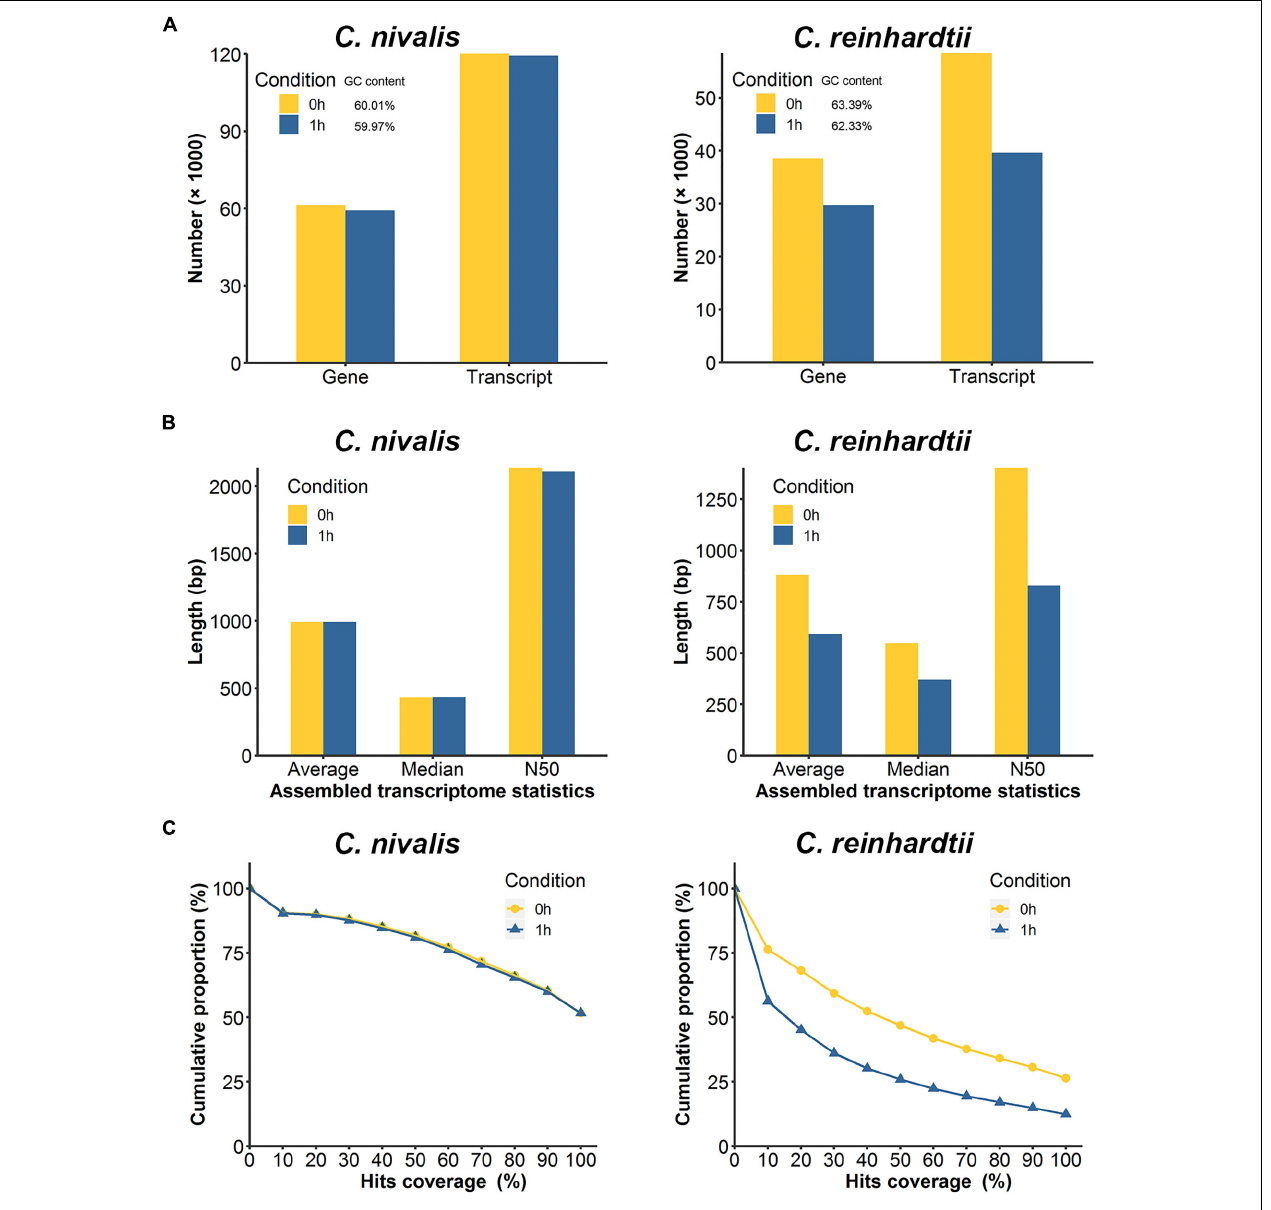
FIGURE 3 | Comparison of de novo assembled transcripts between C. nivalis and C. reinhardtii. (A) Quantity of transcripts and corresponding genes in de novo assembled transcriptomes at 0 h and 1 h (percent GC content is indicated in the legend). (B) The length statistics of the transcriptomes at 0 h and 1 h. For each transcriptome the average, median, and N50 transcript lengths are provided. (C) For each transcriptome, we matched the transcripts to the reference genome, and determined the coverage of the reference gene length aligned to the transcripts, then plotted the cumulative proportions of total reference genes with certain coverage. The starting point of the trend line is set as hits coverage 0% and cumulative proportion